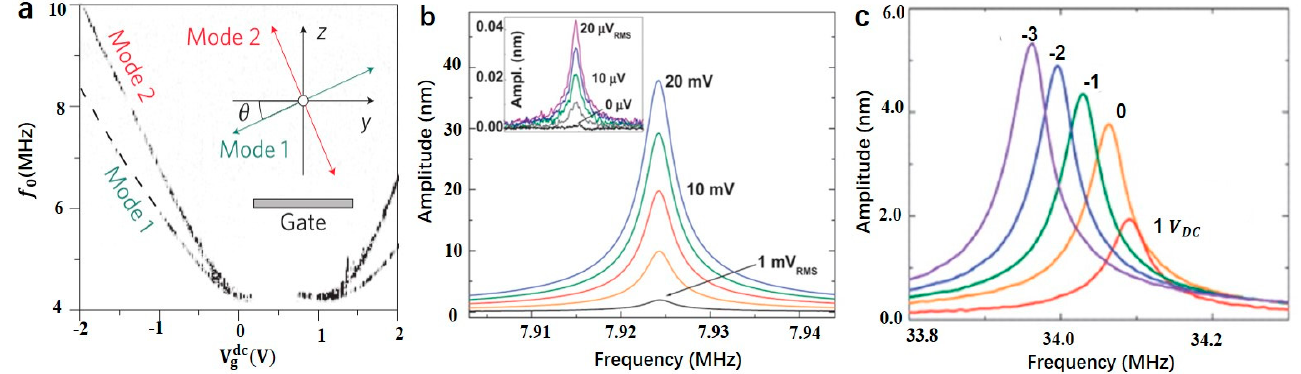
Figure 5. Voltage tuning of the mode, amplitude, and frequency of the resonator. ( a ) Mode splitting occurs when the gate voltage changes. Adapted with permission from [56]. ( b ) The amplitude of resonance depends on the change of AC voltage. Adapted with permission from [47]. ( c ) Fixed AC voltage, resonant frequency depends on the change of DC voltage. Adapted with permission from [47].